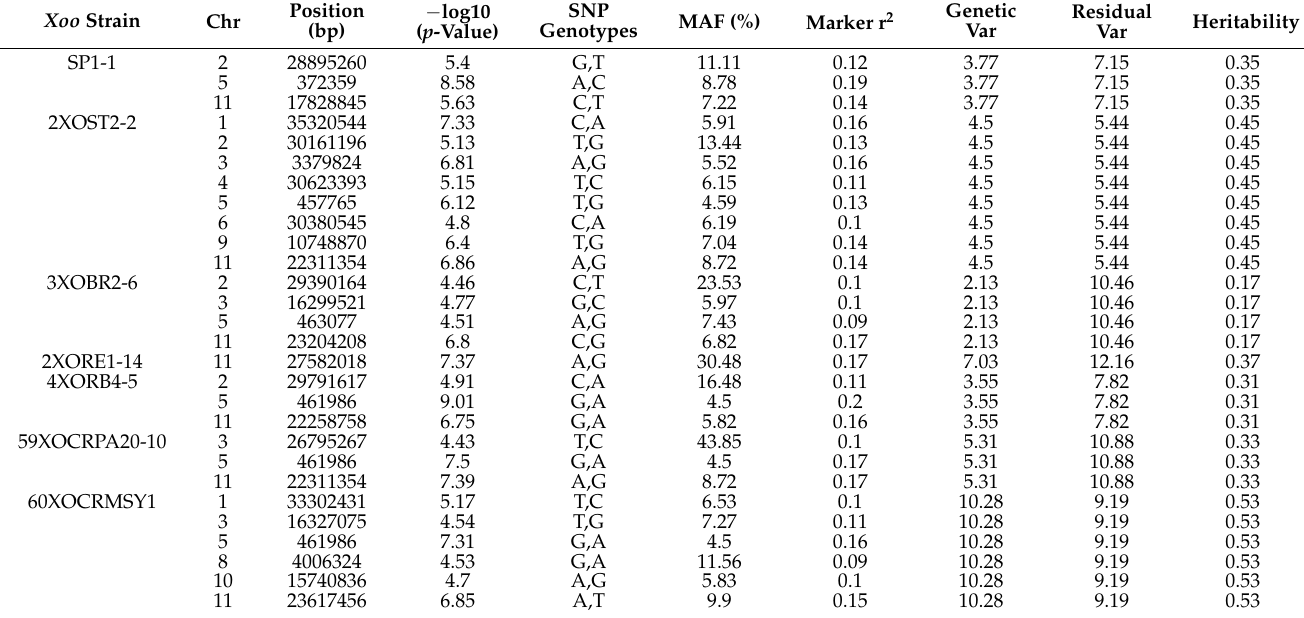
Figure 5. QQ and Manhattan plots from GWAS analyses highlighting significantly associated SNPs associating with bacterial leaf blight resistance for representative Xoo isolates. Figures ( a – i ), Xoo isolates: ( a ) 2XORE1-14; ( b ) 2XOST2-2; ( c ) 3XOBR2-6; ( d ) 4XORB4-5; ( e ) 59XOCRMS9-4; ( f ) 59XOCRMSO3-1-1; ( g ) 59XOCRPA20-10; ( h ) SP1-1; and ( i ) XONS3-2. Dot-dash and dashed lines represent FDR and bootstrap significance thresholds, respectively. Table 1. SNPs associated with BLB resistance across seven Xoo